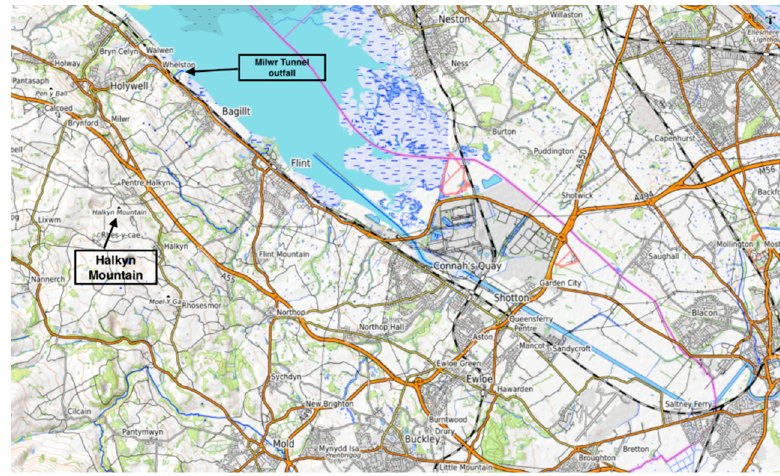
Figure 1. Map of Flintshire showing Halkyn Mountain and the Milwr Tunnel outfall (author’s annotations). Citation: Map courtesy of OpenTopoMap https://opentopomap.org/#map=12/53.2279/-